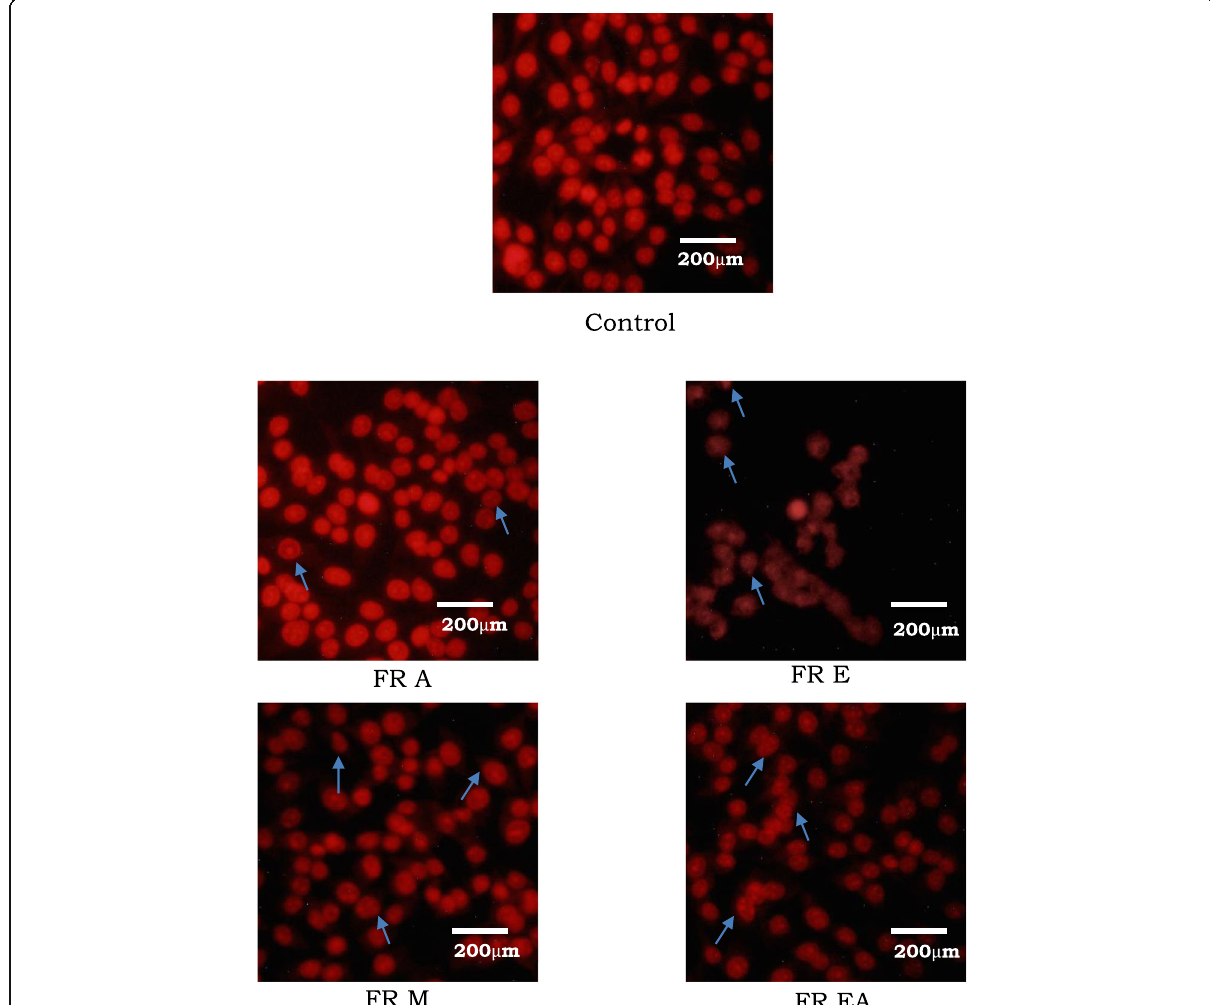
Fig. 6 Morphological changes observed in IMR 32 cells when treated with IC 50 concentrations of F. religiosa latex extracts along with control when stained with propidium iodide. A — acetone; E — ethanol; M — methanol; EA — ethyl